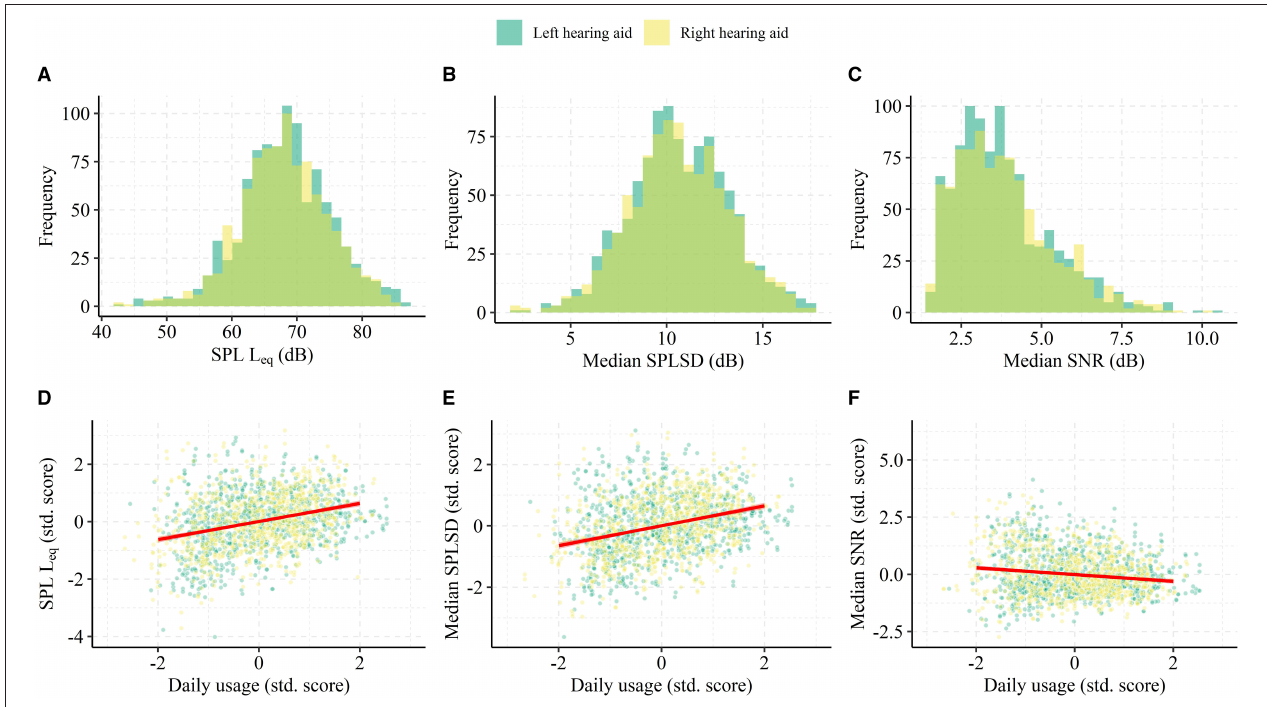
FIGURE 2 | Data for LMM modeling of the association between daily hearing aid usage and the ambient acoustic environment. In (A–C) , histograms of daily SPL L eq , the standard deviation of the SPL (SPLSD), and the daily median SNR pooled from all participants. In (D–F), scatterplots of the acoustic predictors and the daily usage, both in participant-specific standardized score (i.e., Z-score). For visualization of the trends, the red line represents the best linear fit to data within the interval − 2:2 in